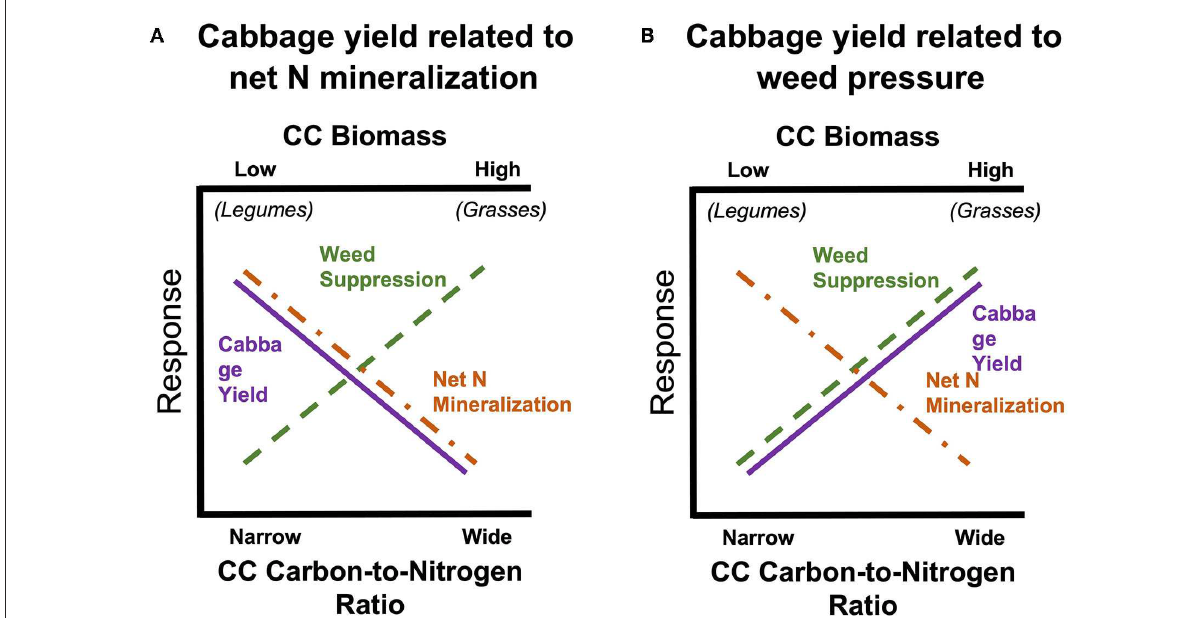
FIGURE1 Conceptual diagram of our hypothesized relationship between cover crop biomass (also carbon-to-nitrogen ratio) and two negative responses: weed biomass and potential net N mineralization. This depicts that there is a “trade-off” between greater plant-available N, weed suppression, and yield.